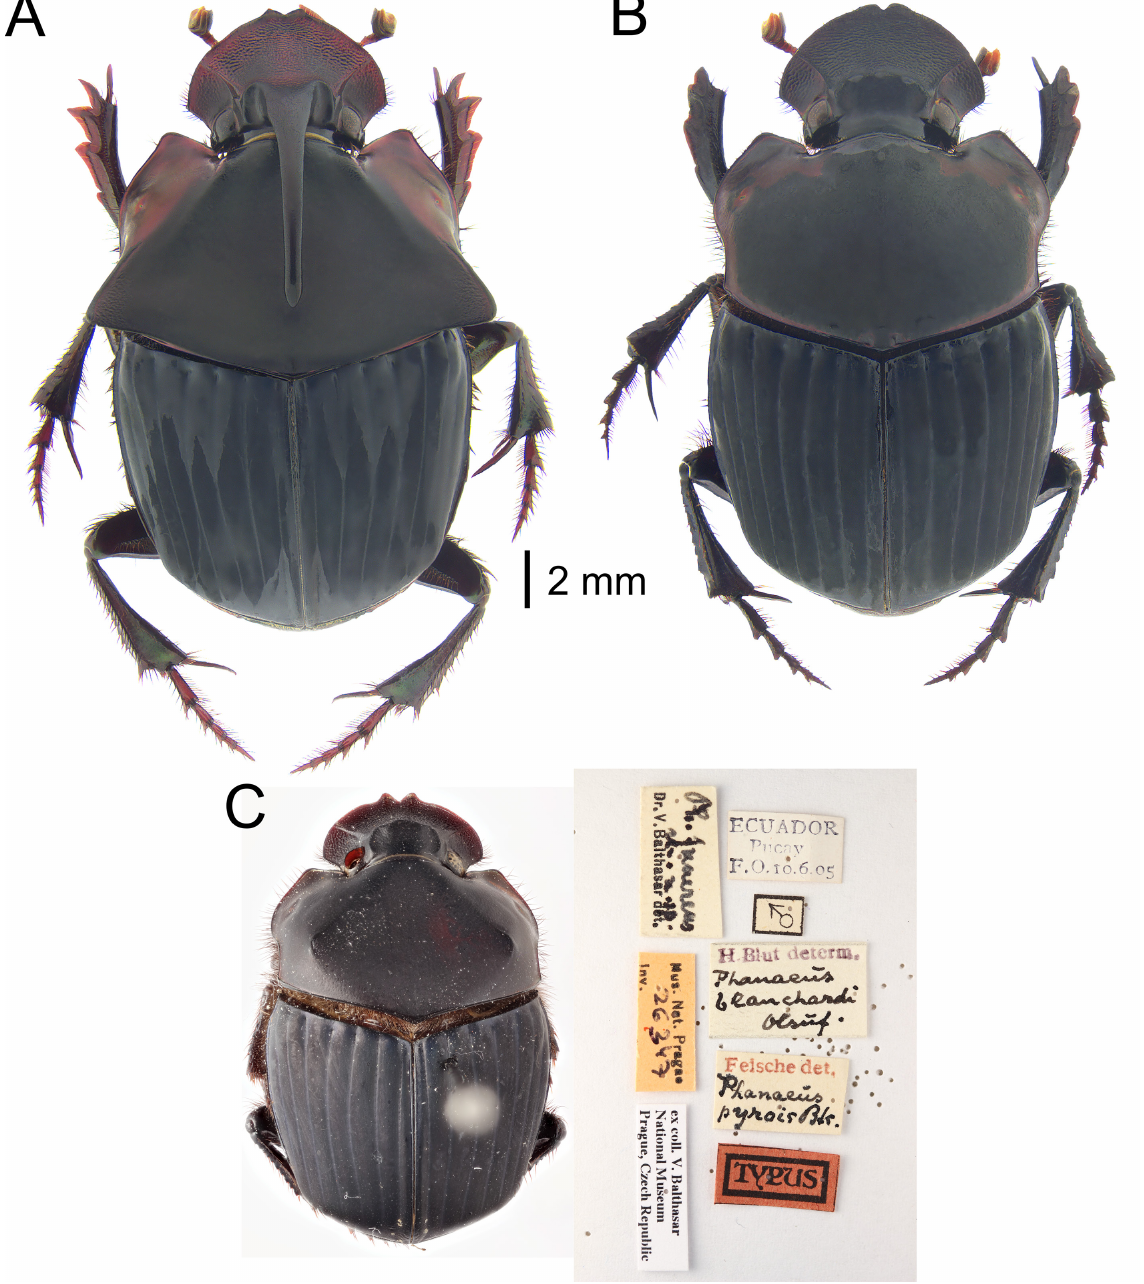
Fig. 5. Phanaeus funereus Balthasar, 1939 stat. rev. A . ♂ (TAMU). B . ♀ (TAMU). C . Holotype, ♂ (by Jiří Hájek, Národní Muzeum, Prague, Czech Republic)